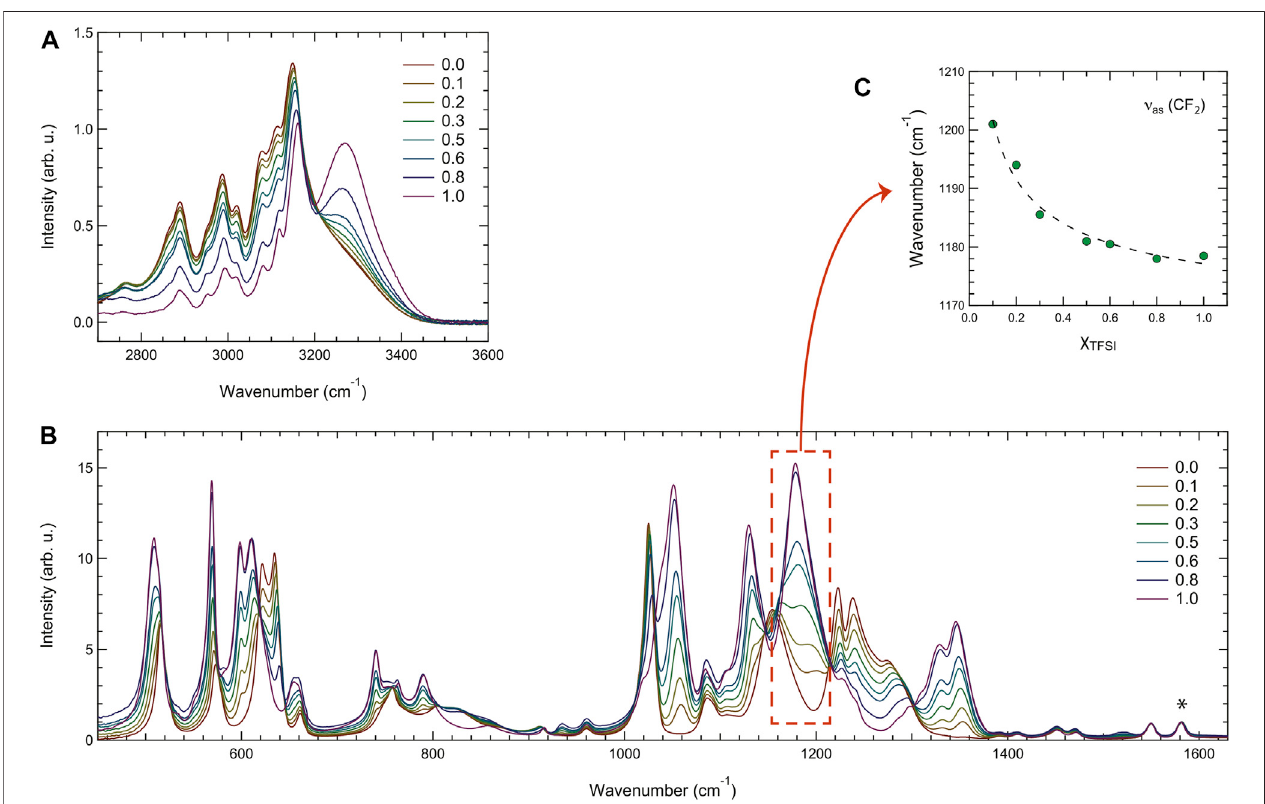
FIGURE 6 | Infrared spectra recorded for all the binary mixtures in the high- (A) , and mid- and low-frequency ranges (B) . The asterisk in the plot (B) indicates the vibrational mode used for normalization. The frequency of the asymmetric stretching mode ( ] as ) in the CF 3 group of TFSI as a function of composition is shown in (C) .